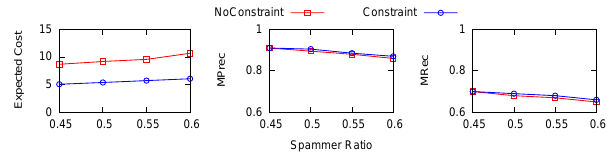
Figure 12. Effects of spammers on answer